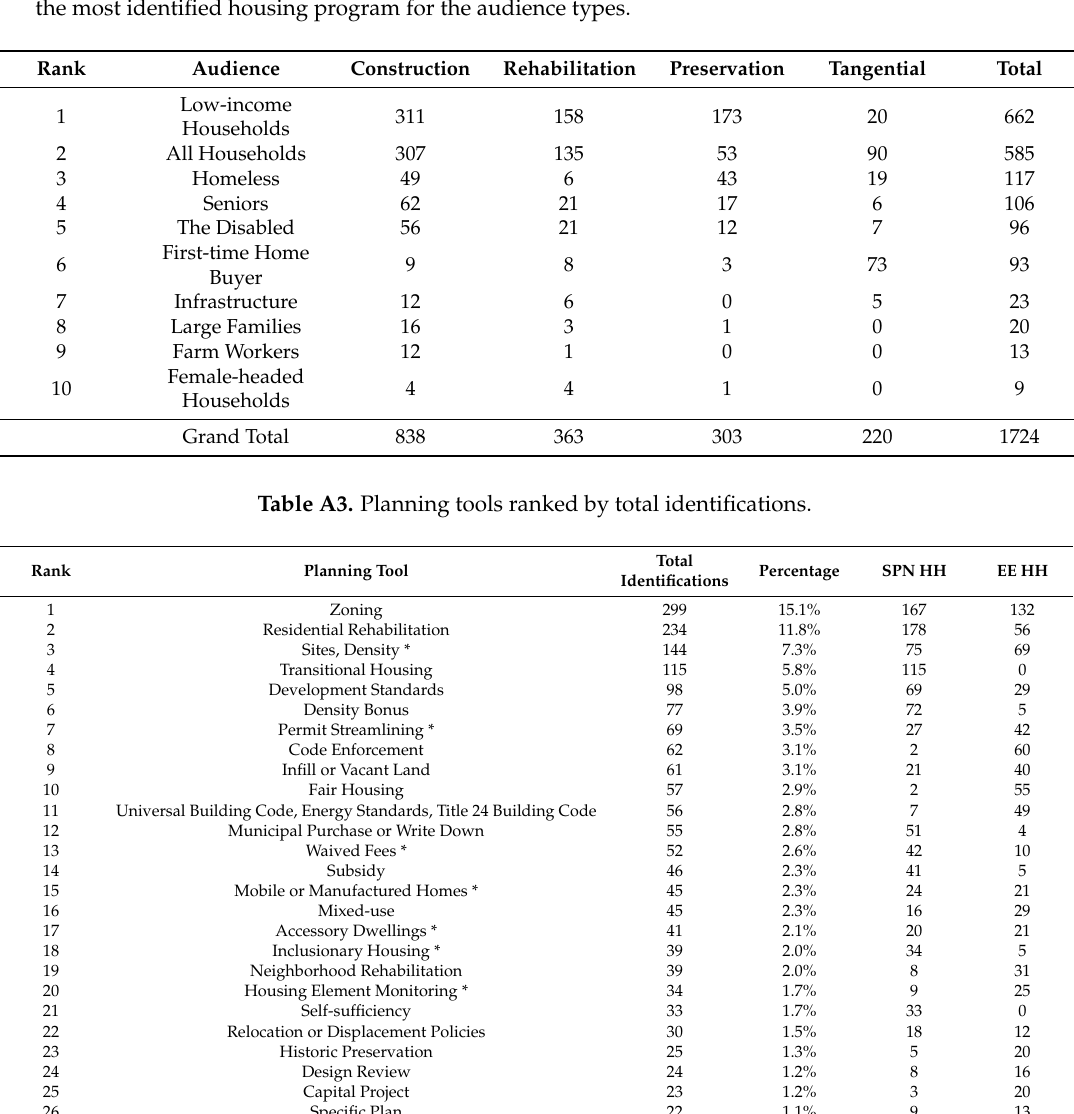
Table A2. Audience types by housing programs. Excepting first-time homebuyers, construction was the most identified housing program for the audience types.